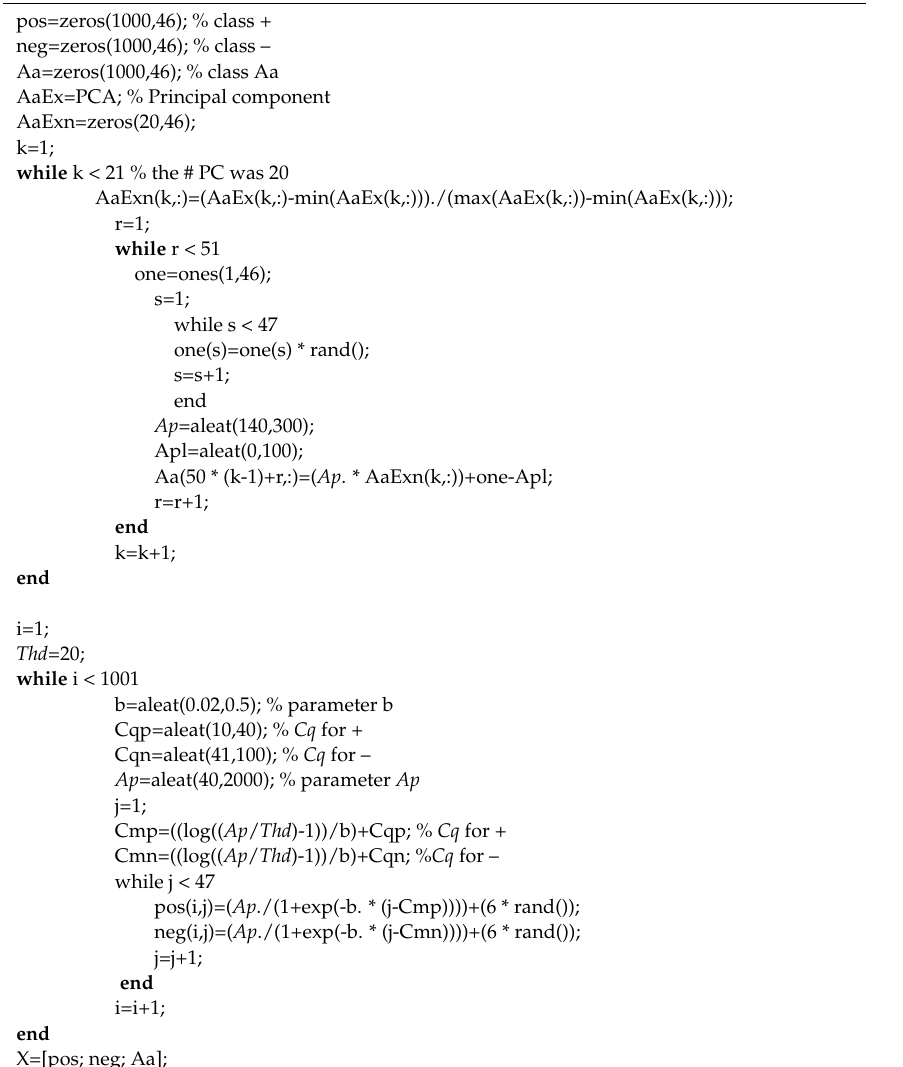
Algorithm 2 Simulation Algorithm Using PC